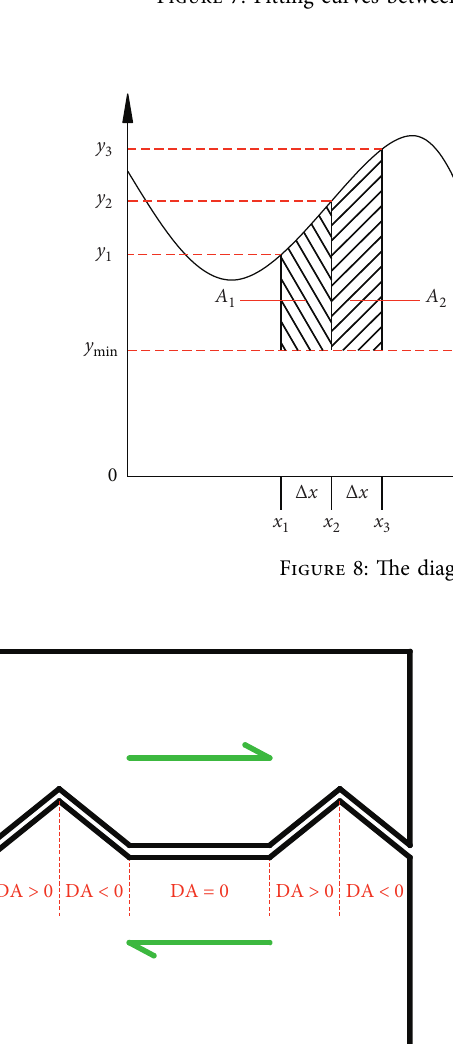
Figure 7: Fitting curves between statistical parameters and JRC. (a) θ +